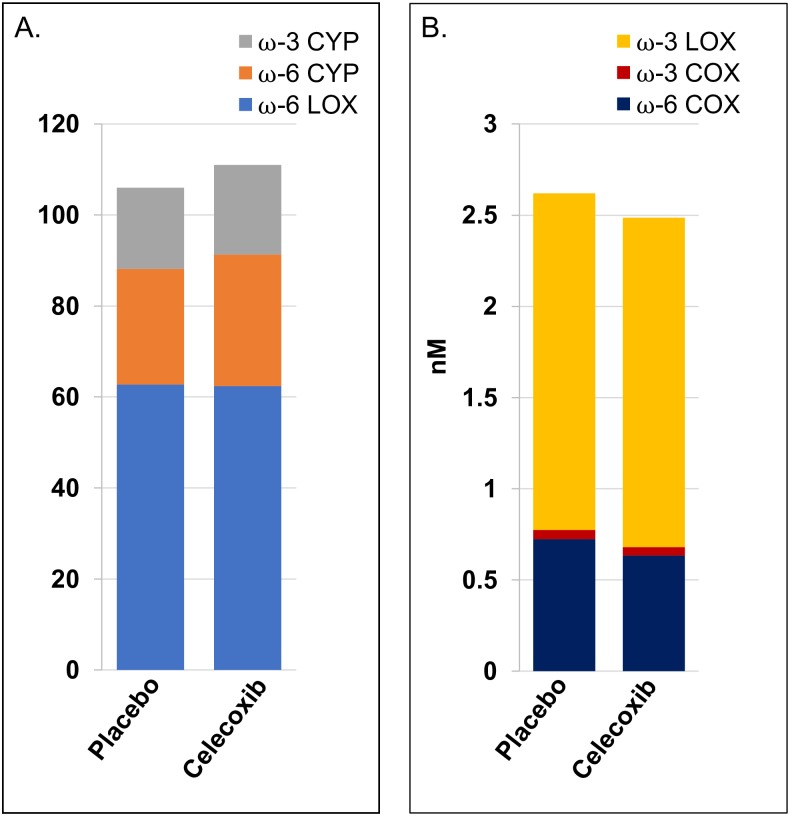
Pathway-based differences for all participants: Celecoxib (n = 90) versus placebo (n = 95).(A) Summed oxylipins from ω-3 CYP450, ω-6 CYP450, and ω-6 LOX pathway arms. Asterisk (*) indicates P = 0.054. (B) Summed oxylipins from ω-3 LOX, ω-3 COX, and ω-6 COX pathways arms. Note that A and B are on different scales. Different colors represent the sum of all quantified oxylipins in a given pathway arm.